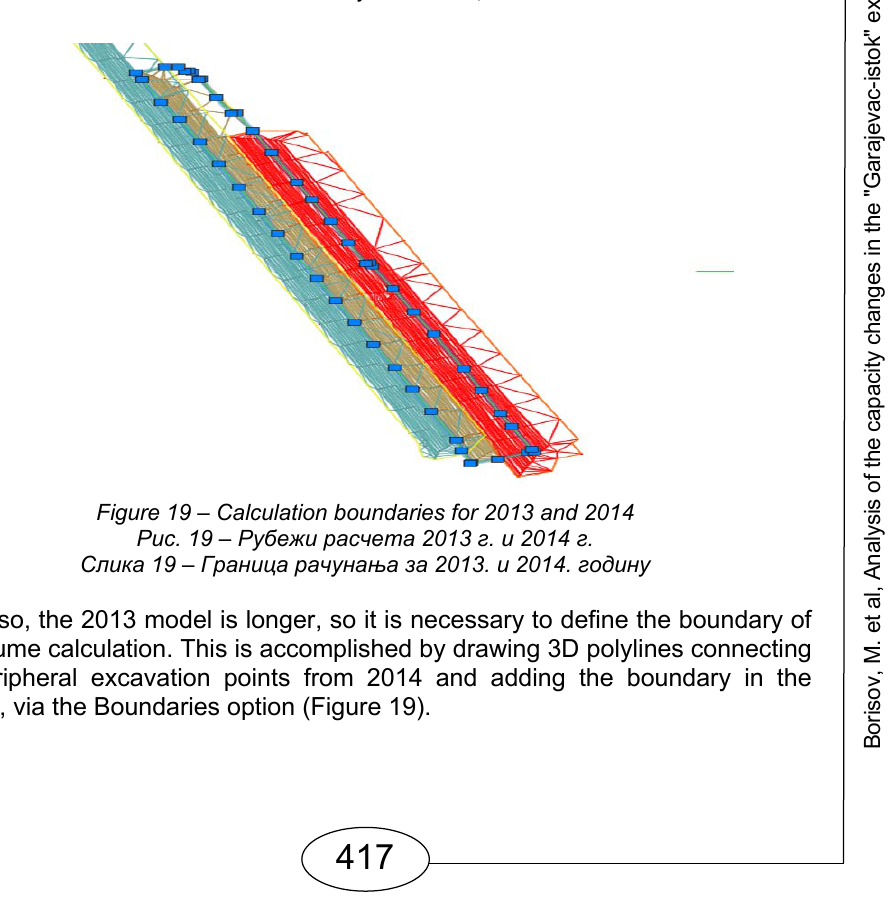
Figure 18 – 2013 model supplemented with the data from 2014 Рис . 18 – Дополненная модель из 2013 года данными из 2014 года Слика 18 – Модел из 2013. године допуњен подацима модела из 2014. године